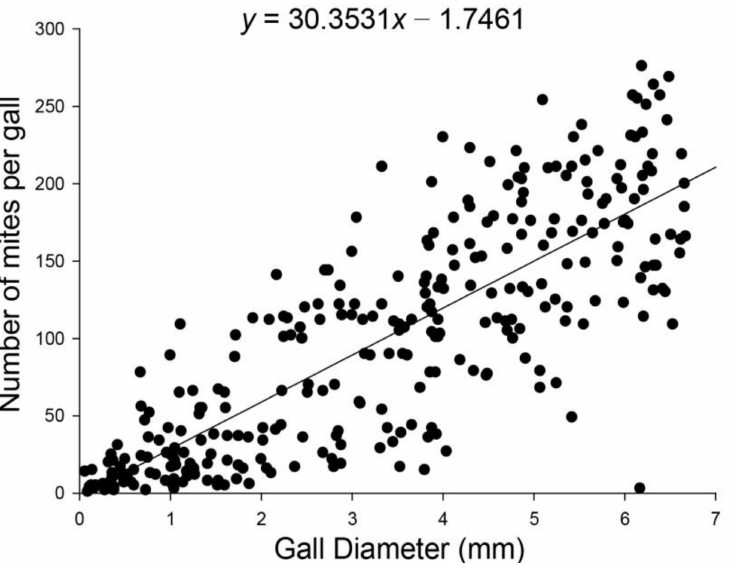
Figure 1. Relationship between the diameter of gall and A. pallida abundance in the gall. The line was fitted using linear regression